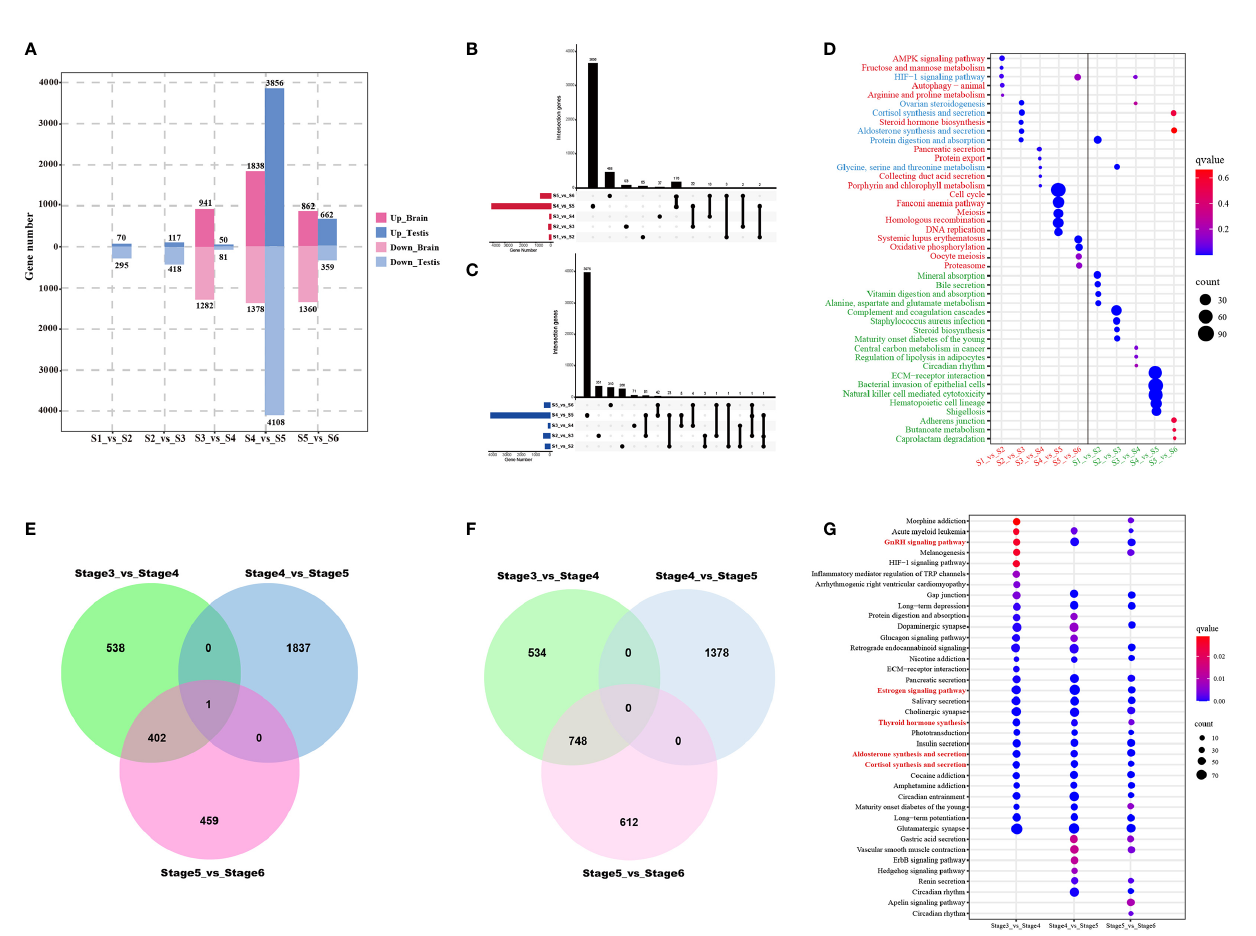
FIGURE 7 | Differentially expressed genes (DEGs) and functional analysis across testicular development from the fi rst stage to the sixth stage. (A) Bar chart showing numbers of DEGs between consecutive time points in the brain and the testes. UpSet plots indicate numbers of the common and stage-speci fi c up-regulated (B) and down-regulated (C) DEGs in the testis. (D) KEGG pathway enrichment map showing the top 5 signi fi cant pathways of upregulated and downregulated testis-speci fi c DEGs for fi ve stage-by-stage comparisons. Red font, green font, and blue font representing pathways enriched by upregulated DEGs, pathways enriched by downregulated DEGs, pathways enriched by upregulated and downregulated DEGs, respectively. Venn diagram representation of the number of common and stage-speci fi c up-regulated (E) and down-regulated (F) DEGs in the brain. (G) KEGG pathway enrichment map showing the top 5 signi fi cant pathways of upregulated and downregulated brain-speci fi c DEGs for three stage by stage comparisons during testis development. Red font, green font, and blue font representing pathways enriched by upregulated DEGs, pathways enriched by downregulated DEGs, pathways enriched by upregulated and downregulated DEGs,